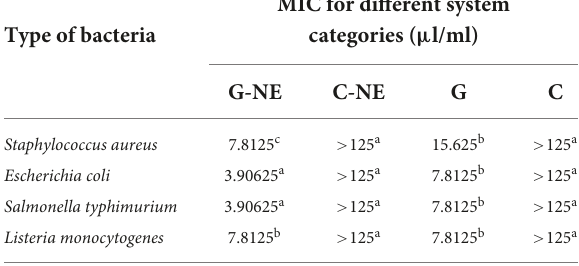
TABLE 5 Minimum inhibitory c oncentration (MIC) of the four model bacteria by different treatments. MIC for different